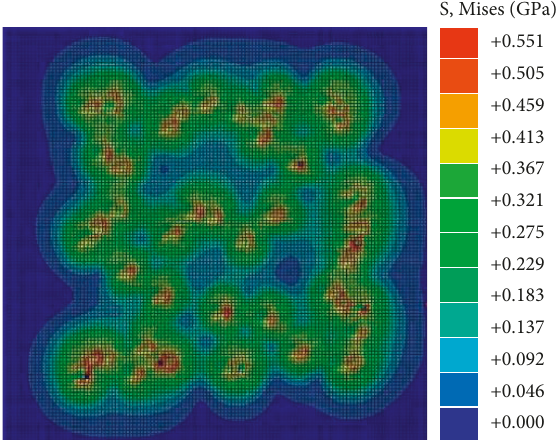
Figure 18: Stress contour impacted randomly by 50 spherical